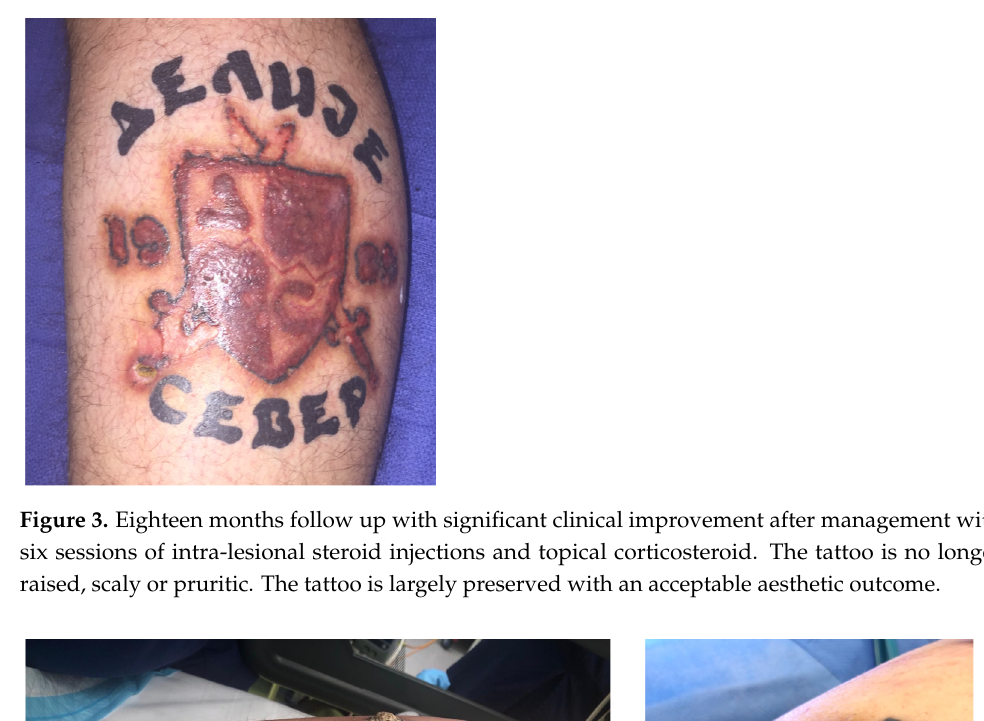
Figure 4. Skin lesion affecting exclusively red-ink tattooed areas 6 months after initial tattoo was completed ( a ). Macroscopic appearance after deep shave biopsy was performed ( b ).